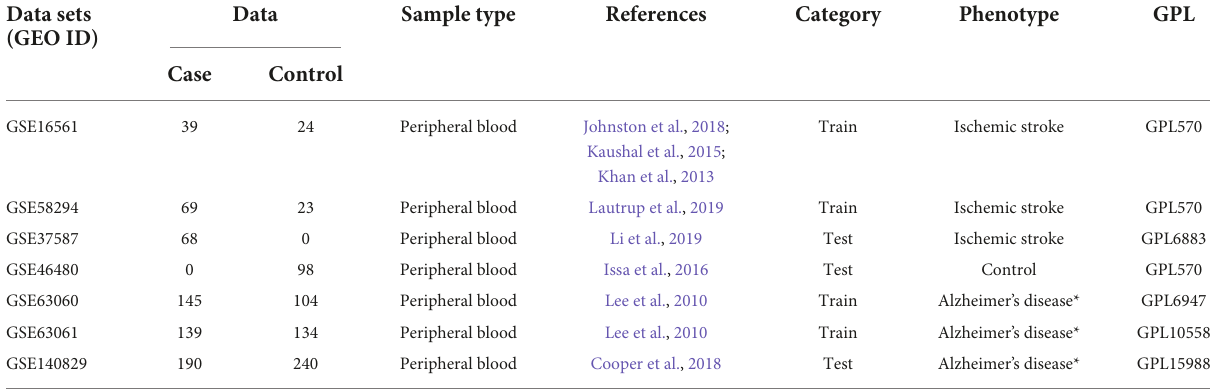
TABLE 1 All data sets used in this study contain a total of 1,273 samples, among which there were 650 cases and 623